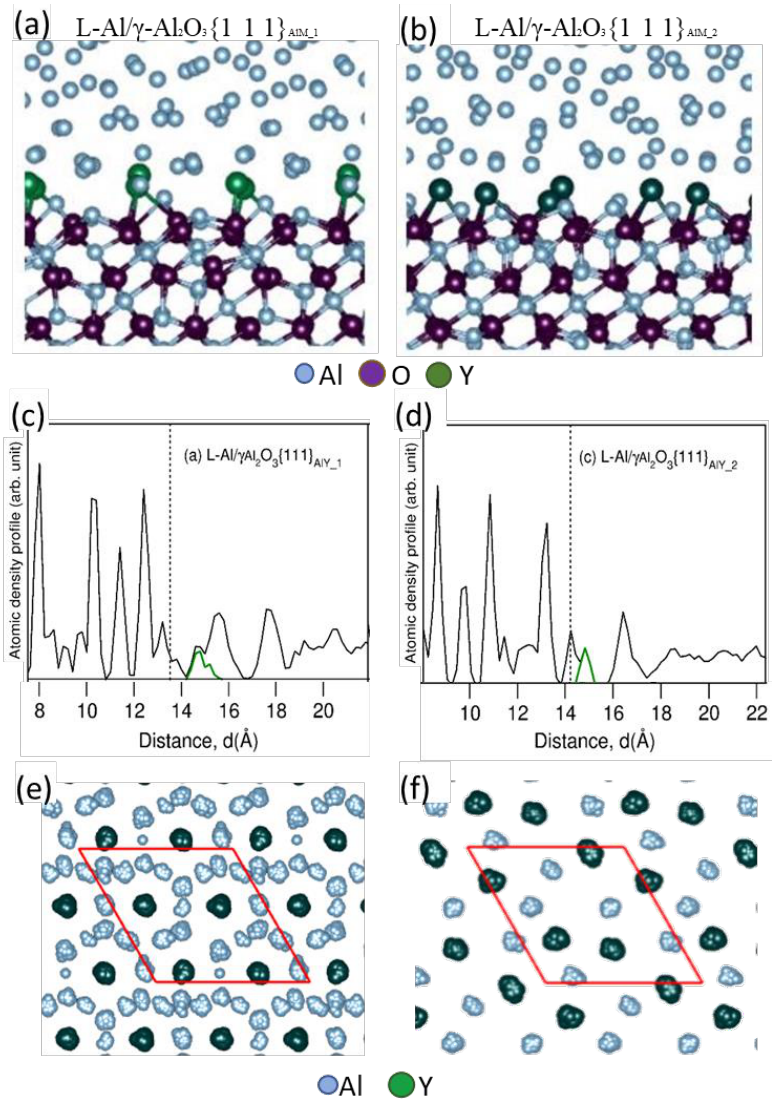
Figure 35. Ab initio molecular dynamics (AIMD) simulation of Y segregation at L-Al/ γ -Al 2 O 3 interface. ( a , b ) Snapshots of Y segregation at ( a ) L-Al/ γ -Al 2 O 3 {1 1 1} AlM_1 and ( b ) L-Al/ γ -Al 2 O 3 {1 1 1} AlM_2 interfaces at equilibrium at 1000 K; ( c , d ) atomic density profiles ρ (z) of Y segregated at the L-Al/ γ -Al 2 O 3 {1 1 1} AlM interfaces where the black curve represents ρ (z) for all atoms, while the dark-green curve is for Y; and ( e , f ) top view of in-plane atomic arrangement of the Y segregation layer at the L-Al/ γ -Al 2 O 3 {1 1 1} AlM interfaces. The blue spheres represent Al atoms, dark-brown O, and dark-green Y.